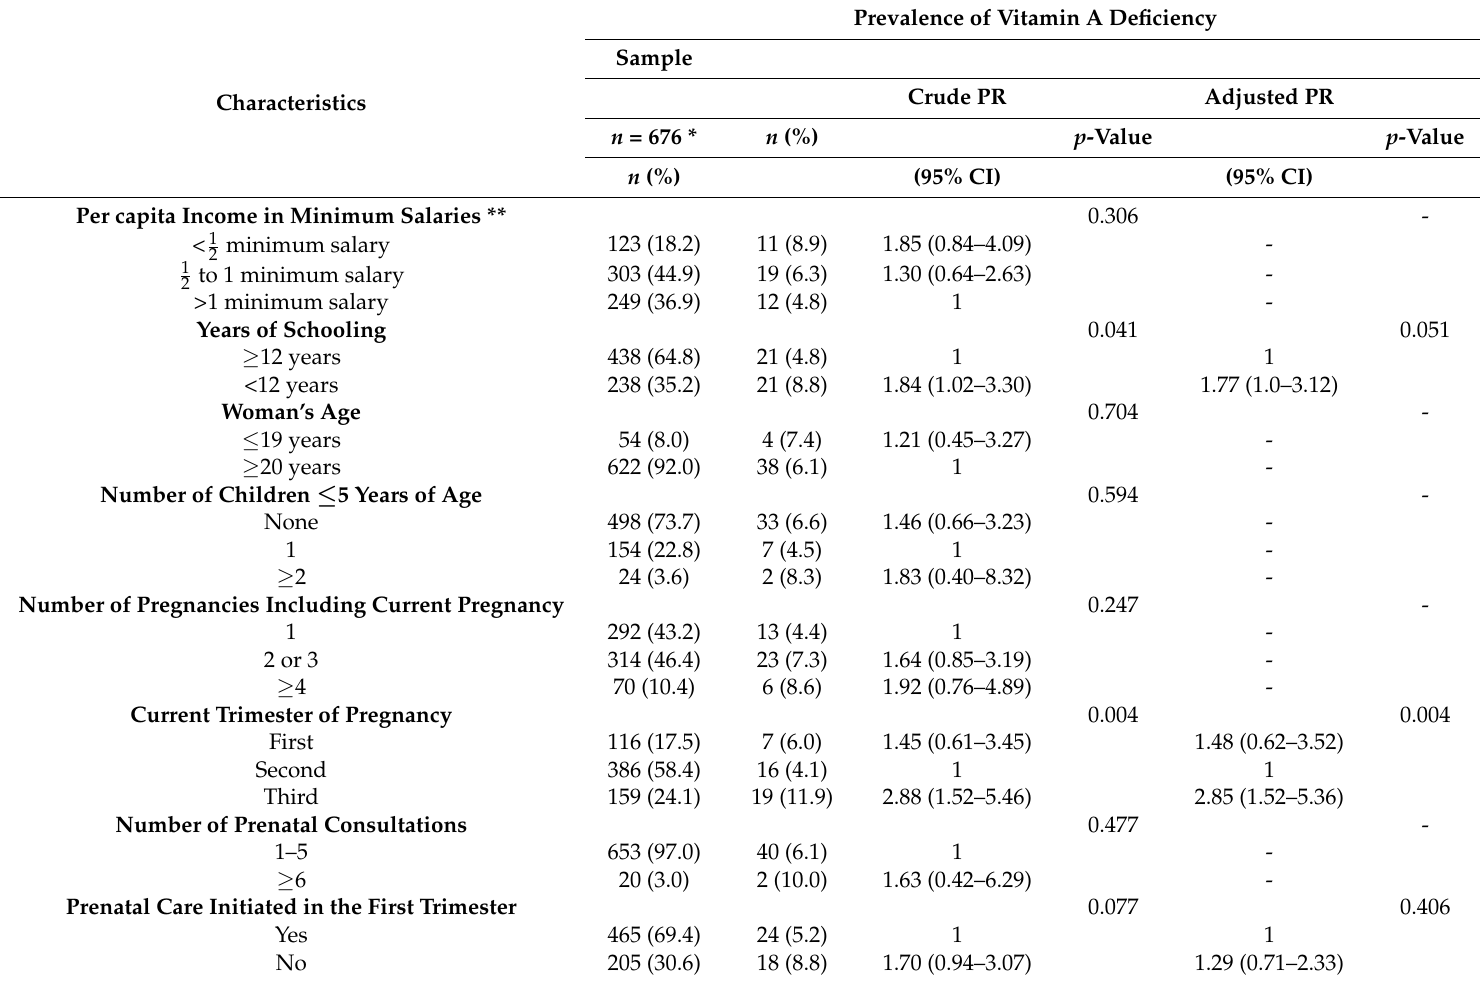
Table 3. Prevalence of vitamin A deficiency according to biological characteristics, obstetric history, prenatal care, and other factors in a group of pregnant women receiving care at the Instituto de Medicina Integral Prof. Fernando Figueira (IMIP), Recife, Pernambuco, Brazil,